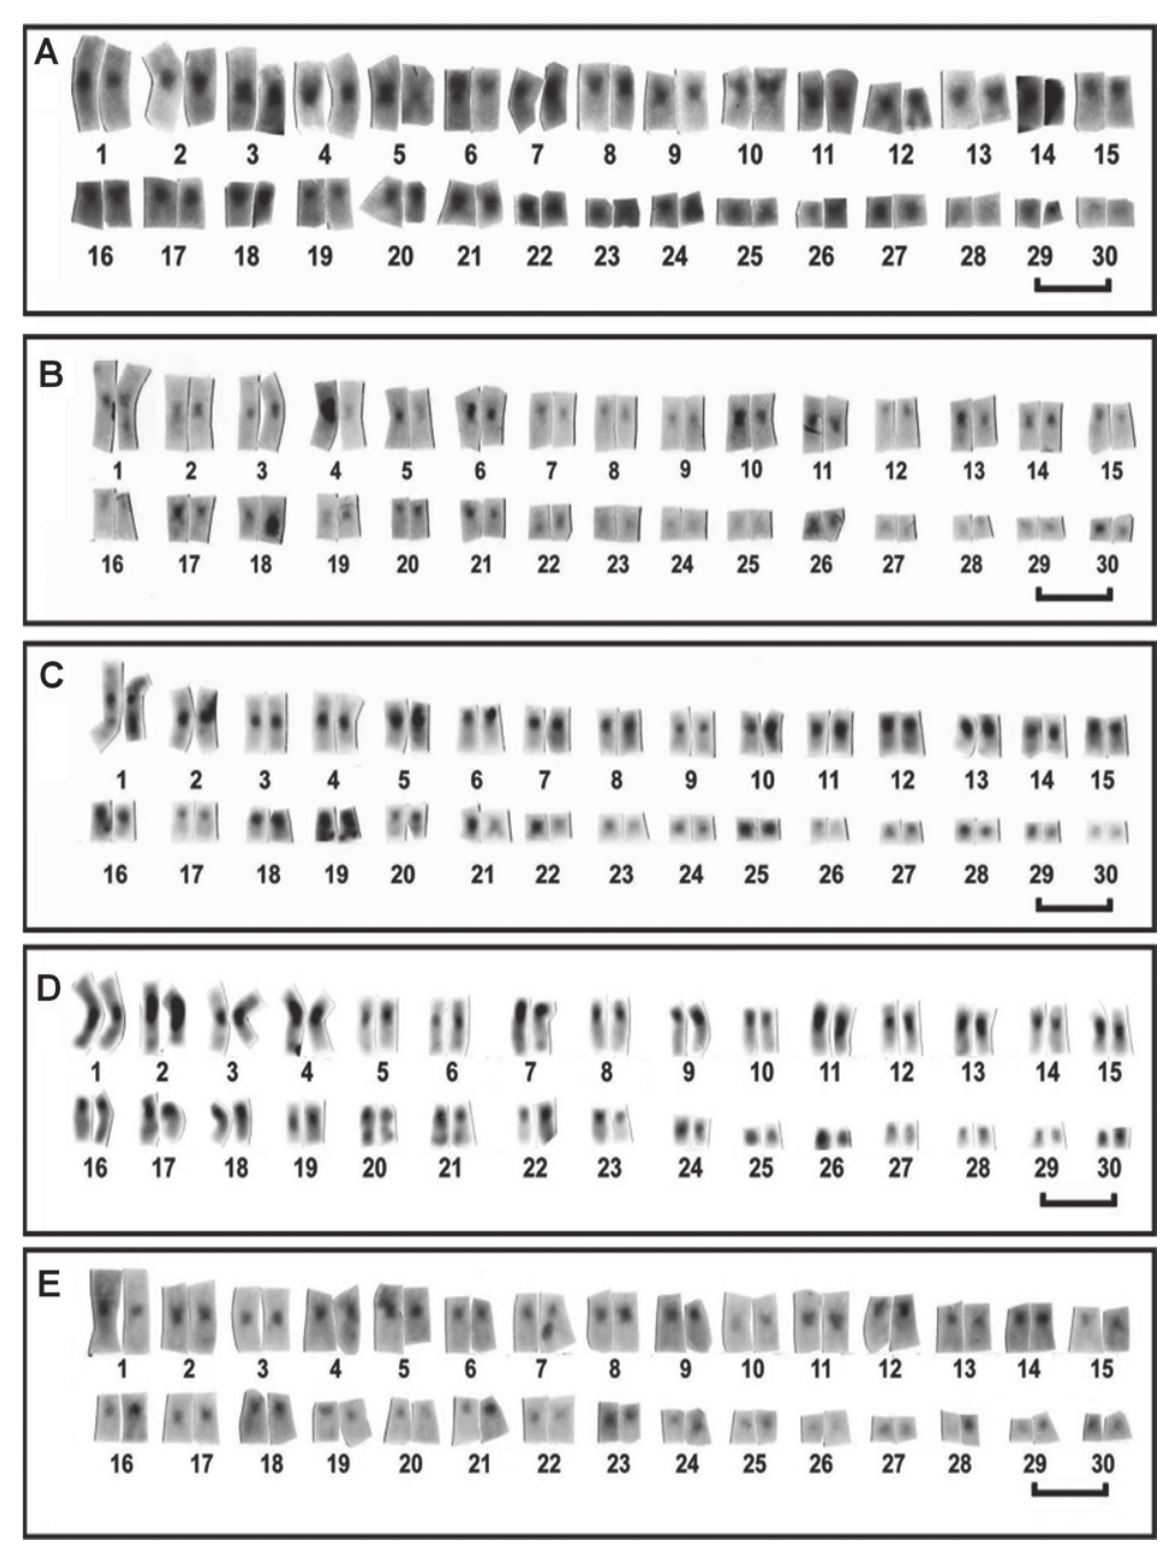
Fig. 5. Karyotypes with C-bands: (A) Symphysodon haraldi from Manacapuru; (B) S. aequifasciatus from Tefé (cytotype 1); (C) S. aequifasciatus from Tefé (cytotype 2); (D) S. discus from Barcelos (cytotype 1); (E) S. discus from Barcelos (cytotype 2). Scale bar represents 5